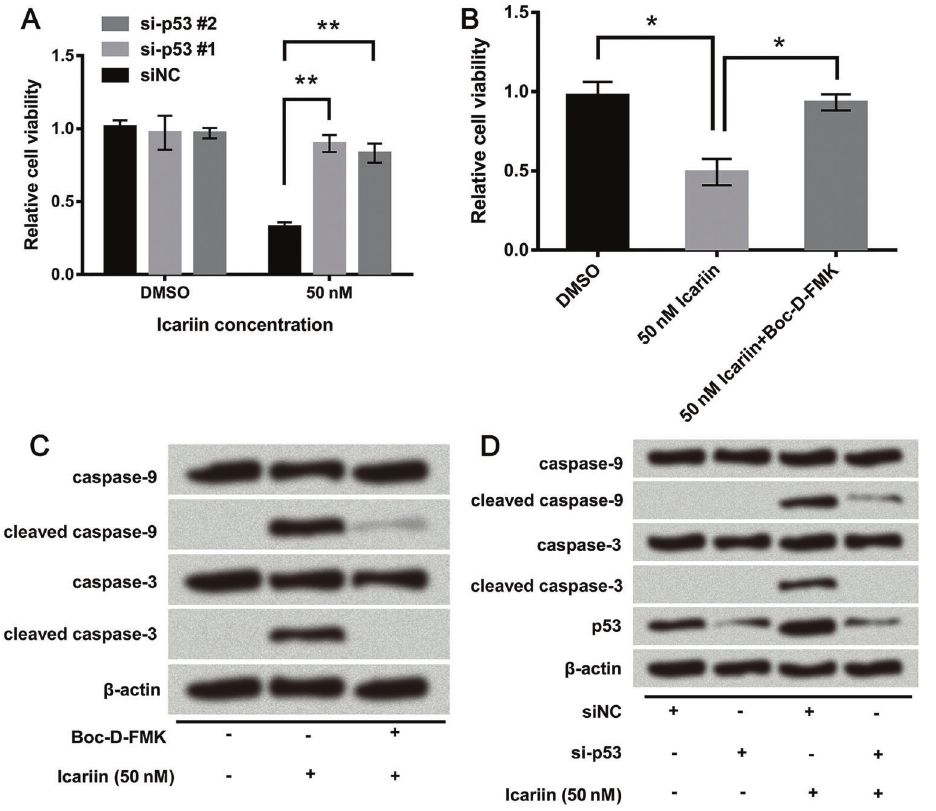
Figure 7. p53 was involved in the anti-tumor effect of icariin by activating caspase-9 and -3. A , Effect of p53 knockdown on cell viability. B , Effect of caspases inhibitor (Boc-D-FMK) on cell viability. Cell viability was determined by CCK-8 assay. C , The effect of caspase inhibitors and D , p53 knockdown on protein levels of caspase-9 and -3 were analyzed by western blot. b -actin was used as internal control. Data are reported as means ± SD. *P o 0.05, **P o 0.01